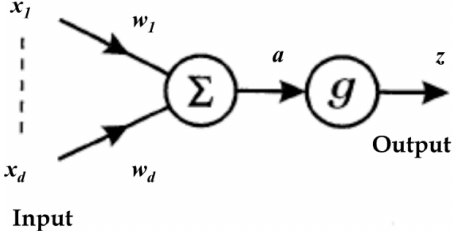
Figure 7. A single processing unit in neural networks.